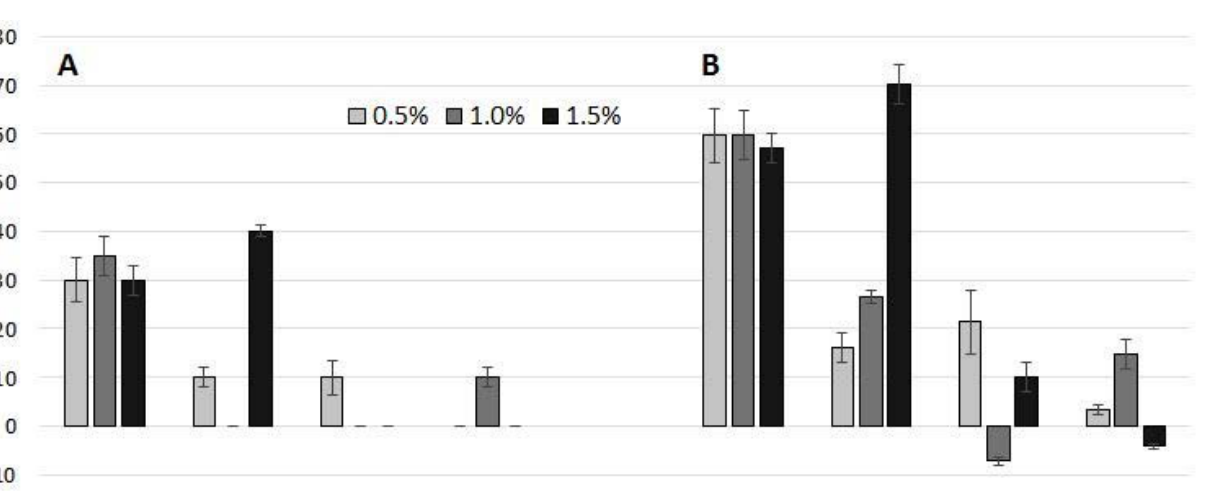
Figure 3. Inhibition of seed germination ( A ) and root growth ( B ) of Lepidium sativum in biochar- amended OECD soil at the dose of 0.5, 1.0 and 1.5%. Error bars represent the standard deviation of the mean ( n = 6) (BCCH—biochar from cricket chitin, BCCR—biochar from micronized